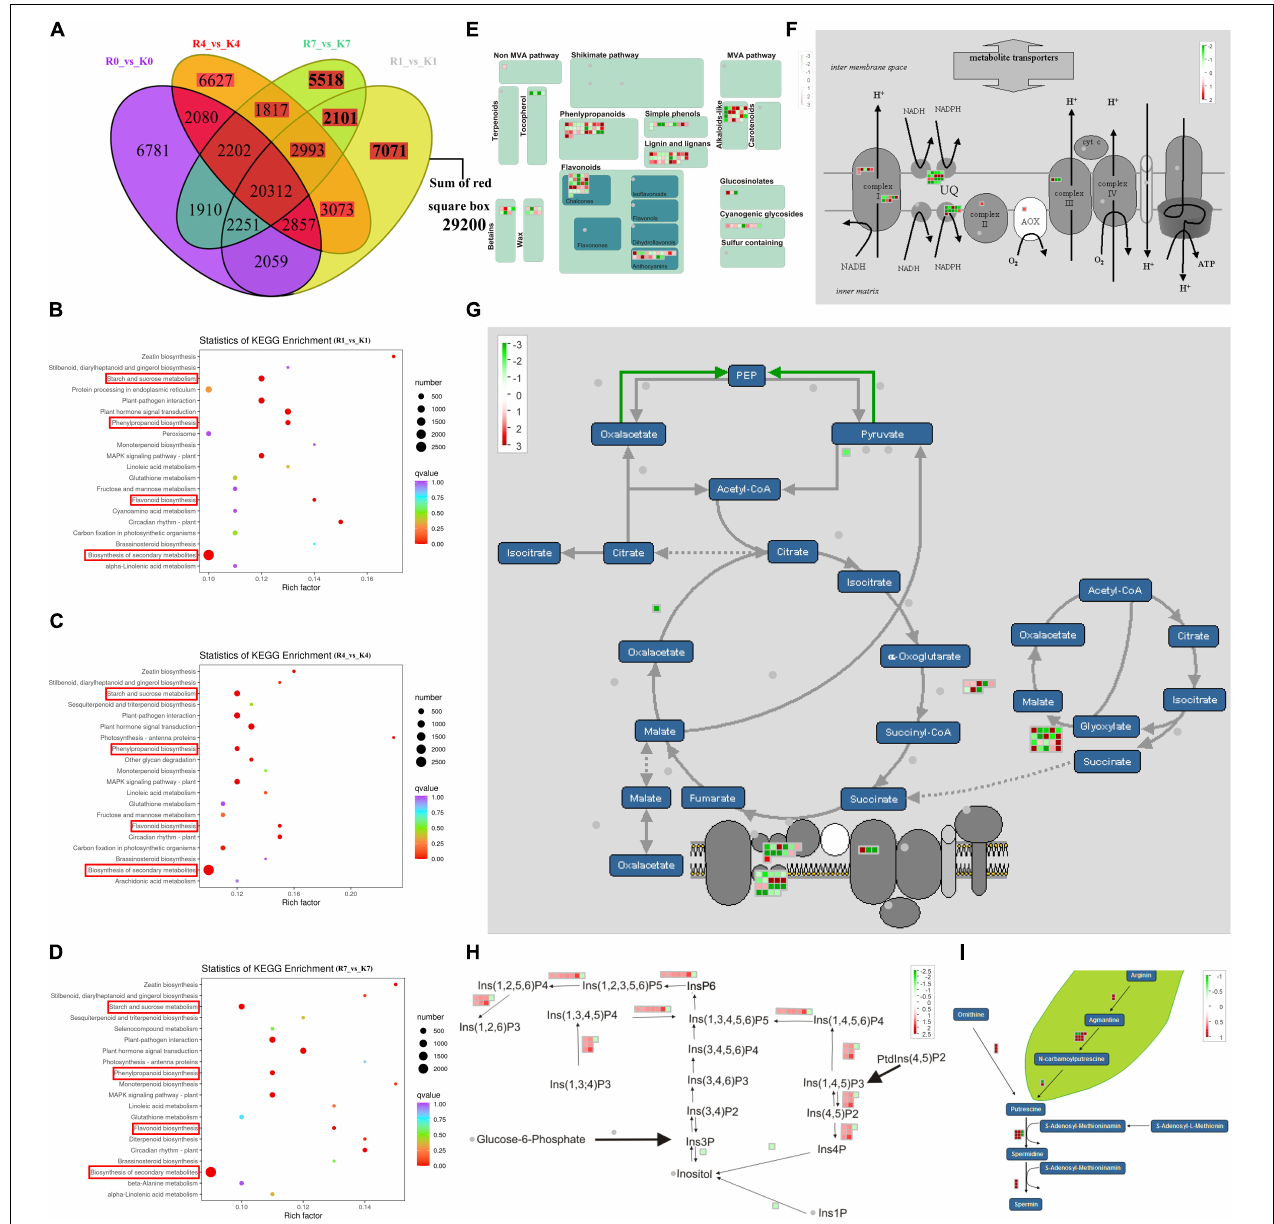
FIGURE 6 | Comparison of the DEGs between KL and RB under the freezing condition. (A) Venn diagrams of DEGs of KL and RB at different treatment time points. (B–D) KEGG pathway enrichment of DEGs at different treatment time points. (E–I) The secondary metabolism, mitochondrial-electron-transport, TCA, inositol phosphates, spermine synthesis pathways, all analyzed via Mapman in DEGs. These values are the medians from log2(fpkm-KL/fpkm-RB) values of the 1 h, 4 h, and 7 h for each DEG. Red and green denote the up-regulation and down-regulation, respectively.